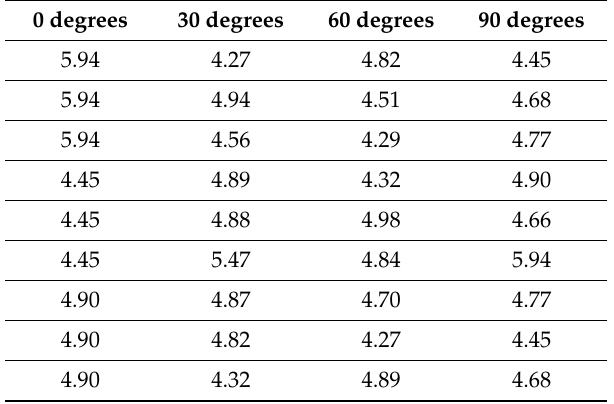
Table 20. DOE setup for percentage elongation as a function of angular orientations.